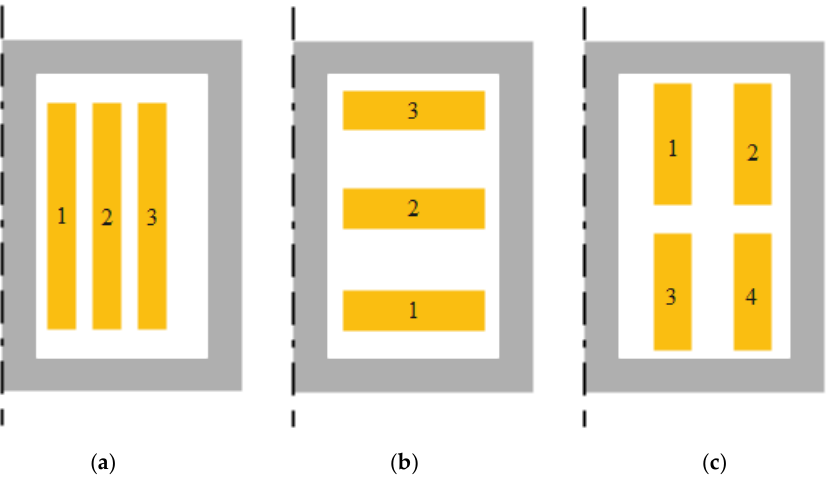
Figure 9. Winding arrangements ( a ) multi-layer ( b ) multi-disk ( c ) mixed. A multi ‐ winding transformer with an integrated rectifier for z secondary windings is shown in Figure 10. Mutual inductance can be separated by mutual inductance of the ( L mcore ) and secondary windings ( L ms ) [37]. C P − S , C S − S , C s , C J , L lks , L ms , R s are indicated by the number of windings.